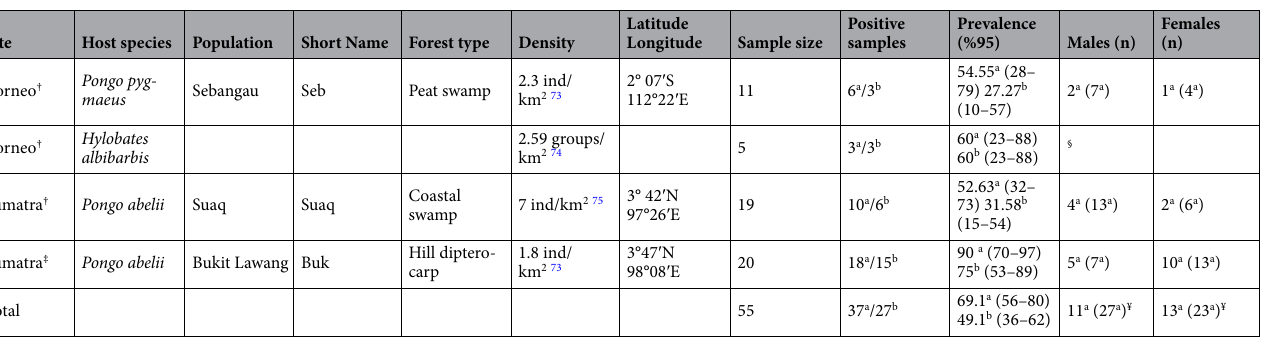
Table 1. Number of Asian ape’s fecal samples collected and sequenced in this study with site, populations, forest type, geographical coordinates, total sample size, and number of infected samples. a Positive samples from microscopy. b Positive samples from PCR. † Populations of free ranging animals. ‡ Populations of semi- wild animals. § 3 of 6 gibbons sex were unknown, data not include in the table. ¥ Infected orangutan samples by